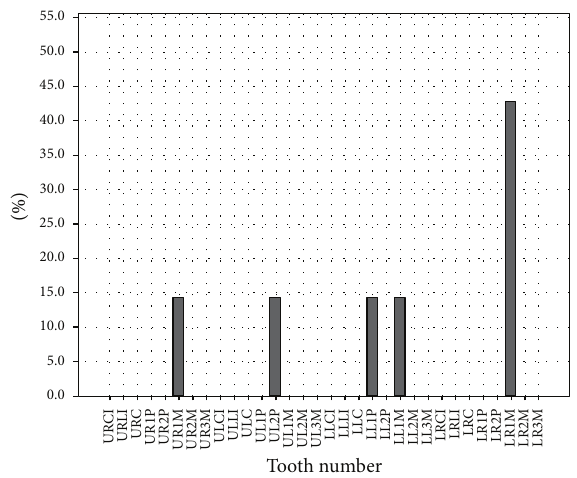
Figure 10: Percentage of apical transportation in individual teeth.